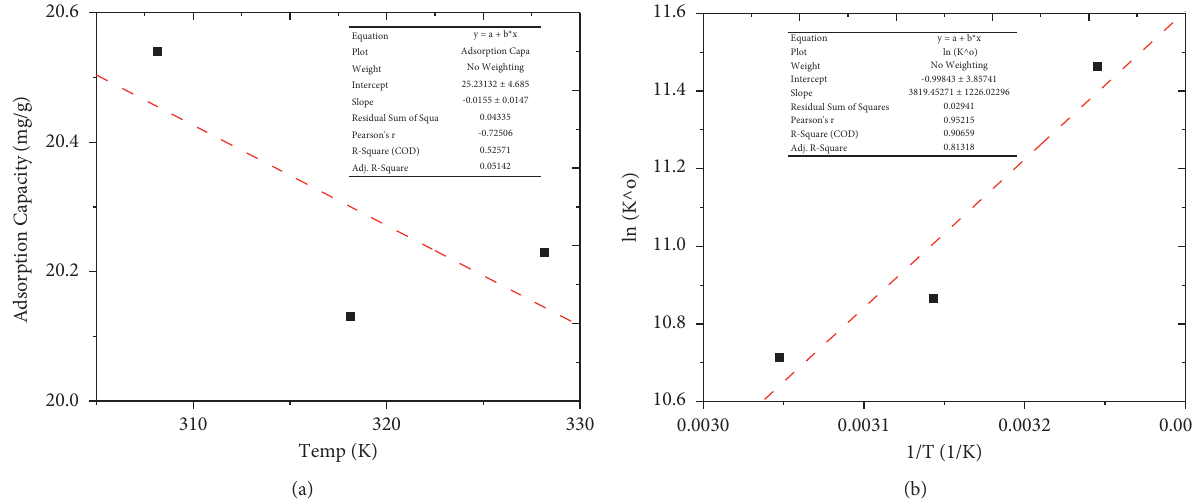
Figure 10: HAP:BENT adsorbent (24mg) adsorption data analysis at 60min of contact time and pH � 5.8 regarding (a) the influence of temperature and (b) Van’t Hoff plot for thermodynamical